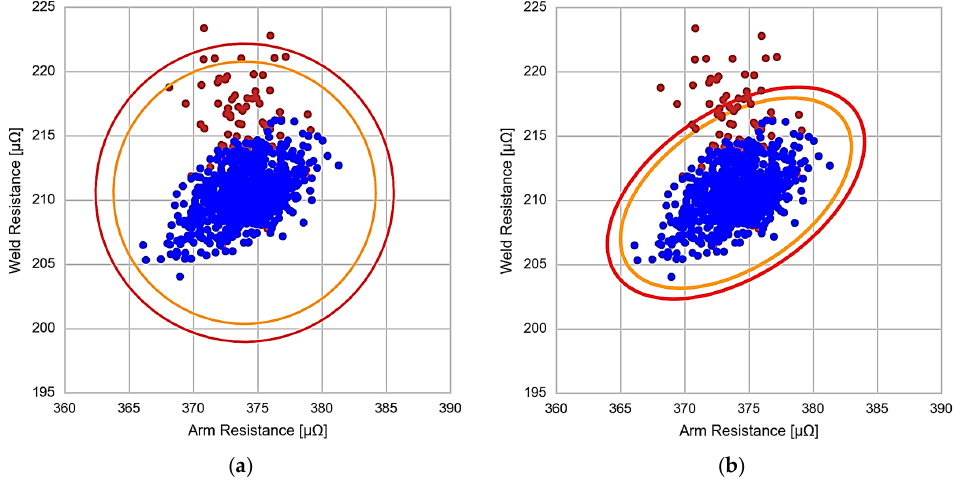
Figure 8. Incipient wear detection. ( a ) Euclidean distance. ( b ) Mahalanobis distance.